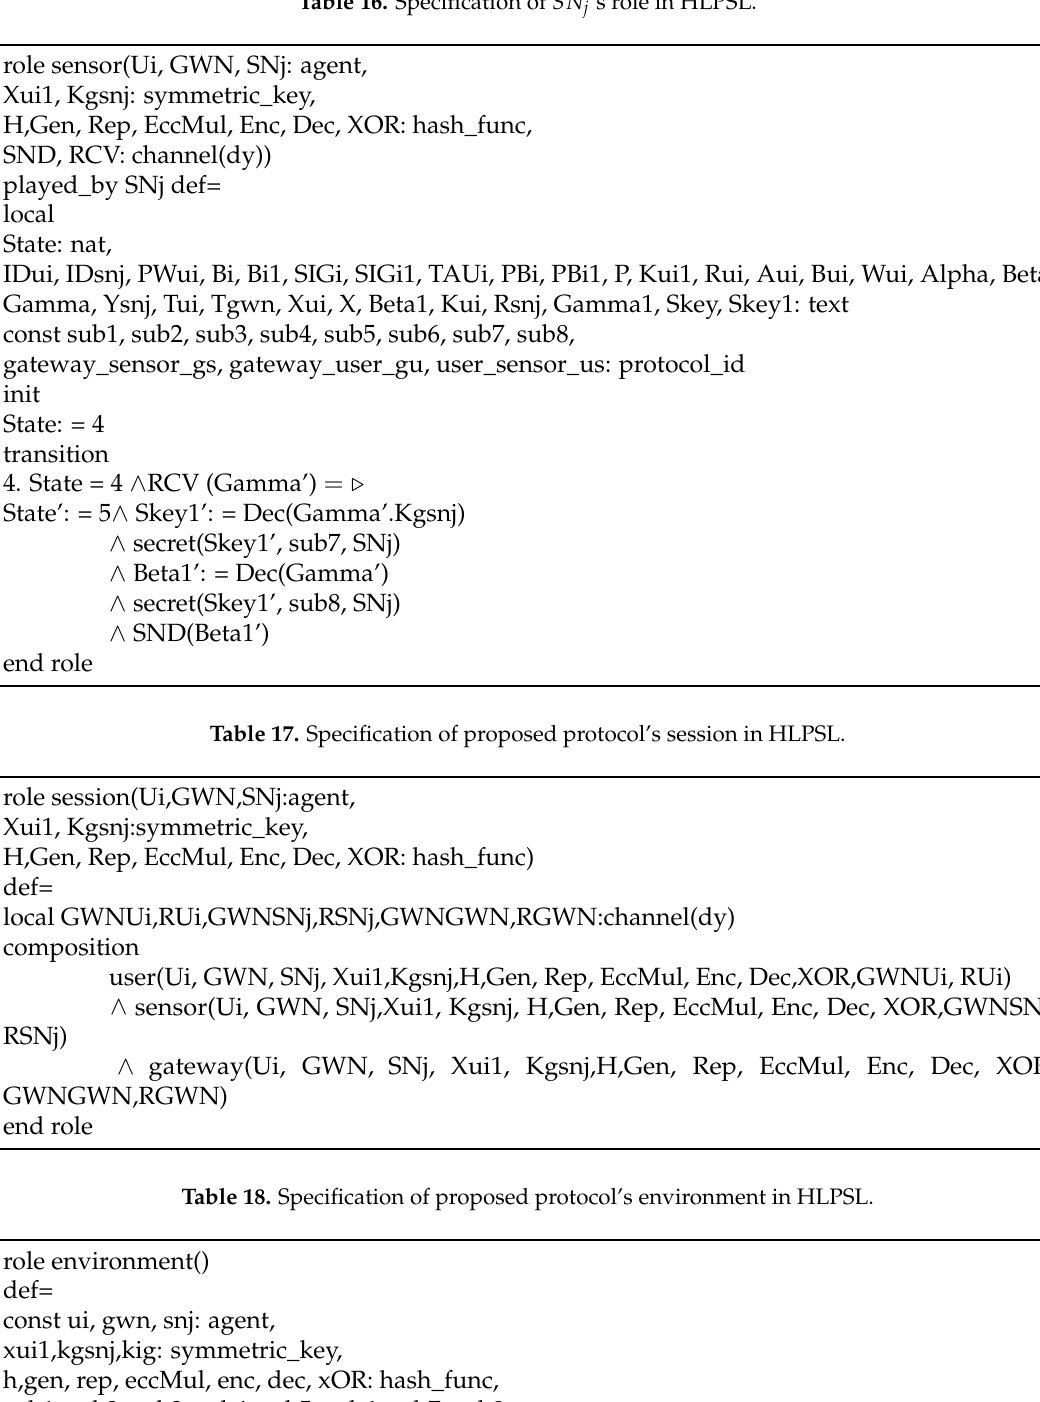
Table 16. Specification of SN j ’s role in HLPSL.